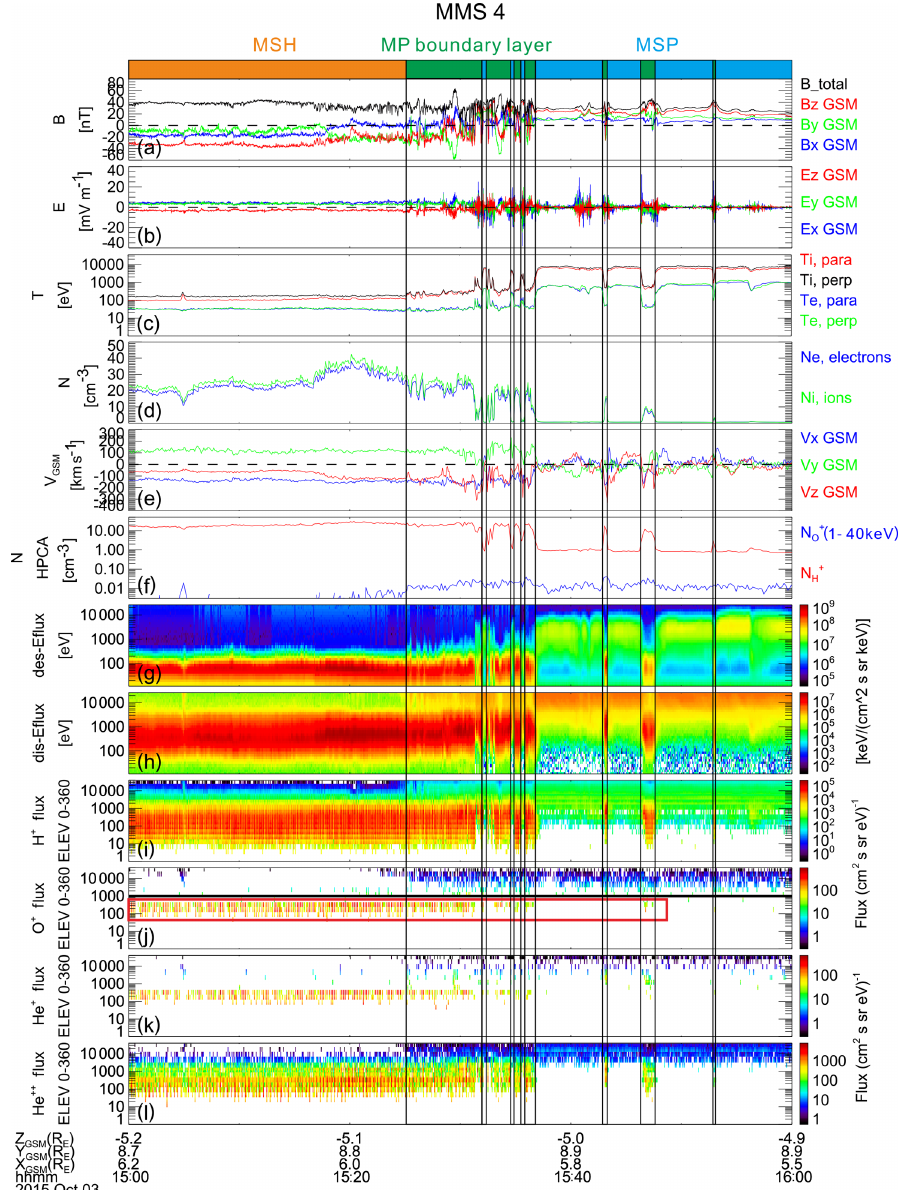
Figure 2. The energetic O + is observed at the magnetopause during an intense substorm on 3 October 2015 by MMS4. From top to bottom are (a) the magnetic field three components, B x (blue line), B y (green line), and B z (red line), and the total magnitude B t (black line), (b) the electric field three components, E x (blue), E y (green), and E z (red), (c) ion parallel (red) and perpendicular (black) temperatures, as well as electron parallel (blue) and perpendicular (green) temperatures, (d) the density of ion (green) and electron (blue), (e) three components of the ion velocity, (f) the H + (over the full HPCA energy range from 1eV to 40keV) and O + (at energies from 1 to 40keV) densities, (g–h) electron and ion omnidirectional differential energy fluxes (keV(cm 2 ssrkeV) − 1 ), and (i) to (l) present differential particle fluxes (cm 2 ssreV) − 1 of H + , O + , He + , and He ++ , respectively. The Geocentric Solar Magnetospheric coordinate system is adopted. The thick bars at the top of the panel present different regions encountered on this magnetopause crossing event. The orange and blue bars represent the magnetosheath and the magnetosphere, respectively. The green bar represents the magnetopause boundary layer. The black horizontal line in (j) is at 1keV and the O + contamination from high H + fluxes is indicated by the red box. The FPI data in (c) – (e) and (g) – (h) are from FPI L2 data products and in the fast